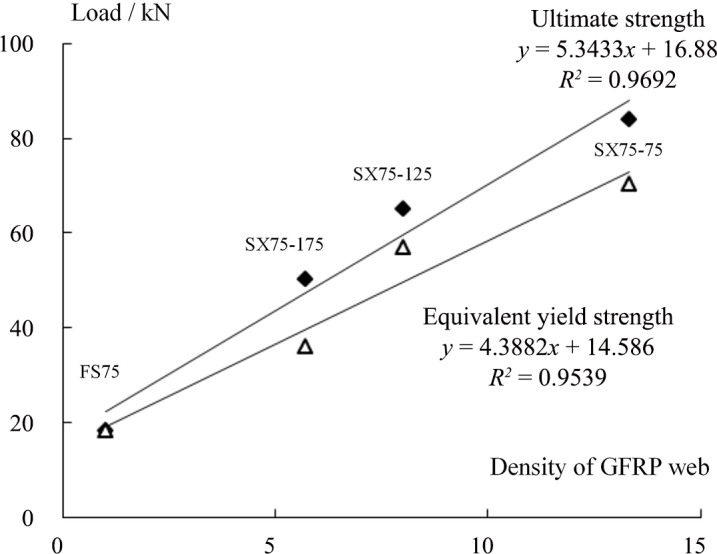
Relationship between the specimen load and web density.